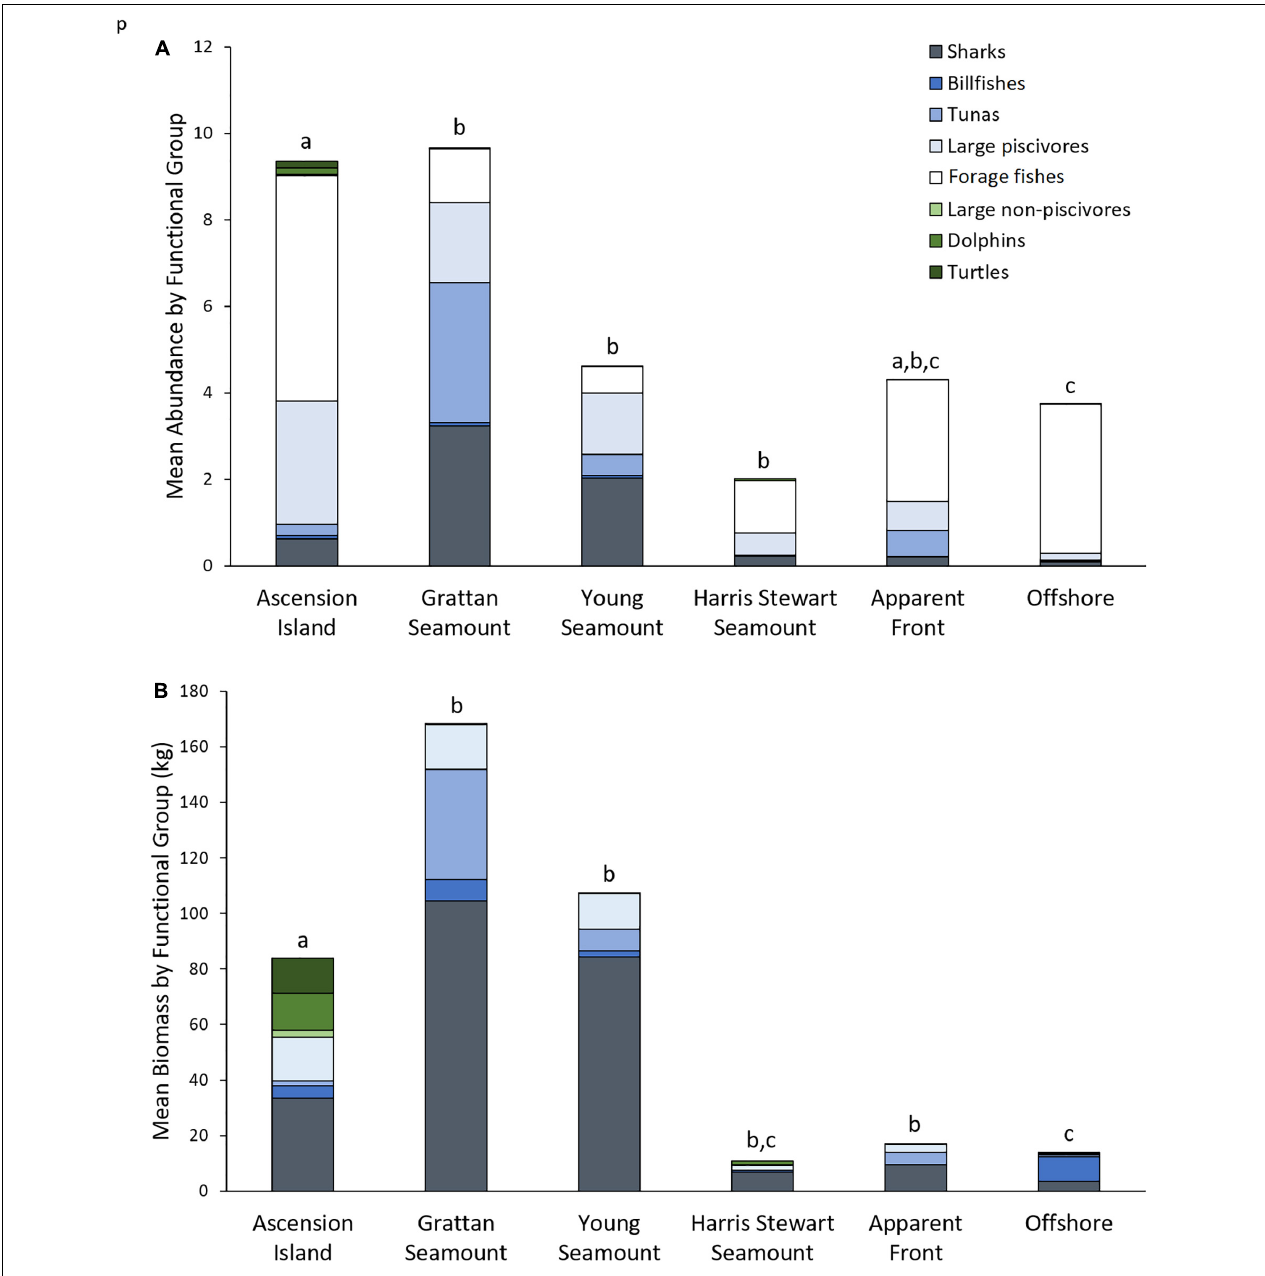
FIGURE 3 | Mean total abundance (A) and mean total biomass (B) for functional groups observed per set of mid-water BRUVS deployed at each of the features sampled within the Ascension Island EEZ. Letters indicate pairwise comparisons of PERMANOVAs based on Bray-Curtis resemblance matrices of square root transformed Total Abundance and Total Biomass data by functional group. Shared letters indicate no significant difference in functional composition ( p >